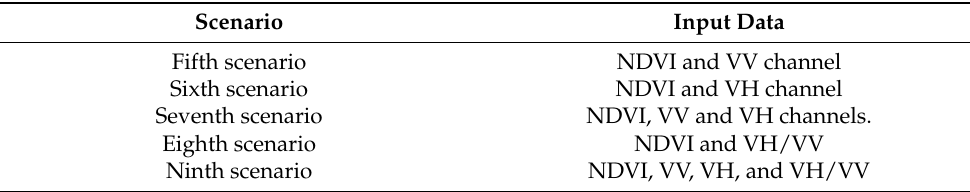
Table 2. Input data of the scenarios of the second approach.